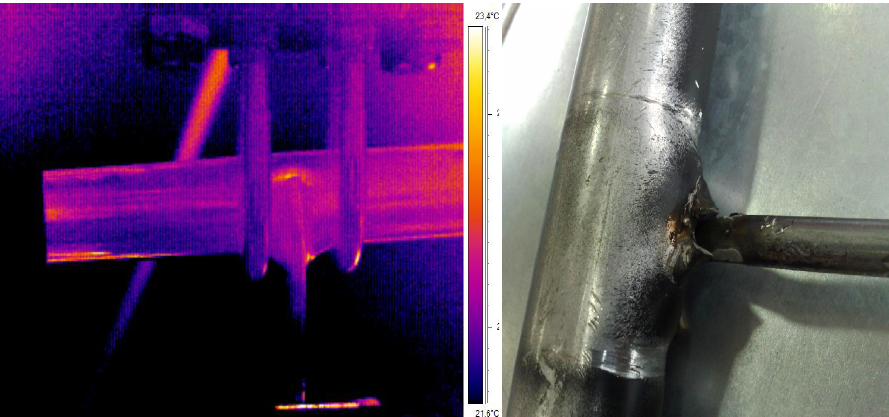
Figura 8: Immagine termica che evidenzia l’inizio della plasticizzazione nella zona di saldatura. Condizione del componente a fine prova.